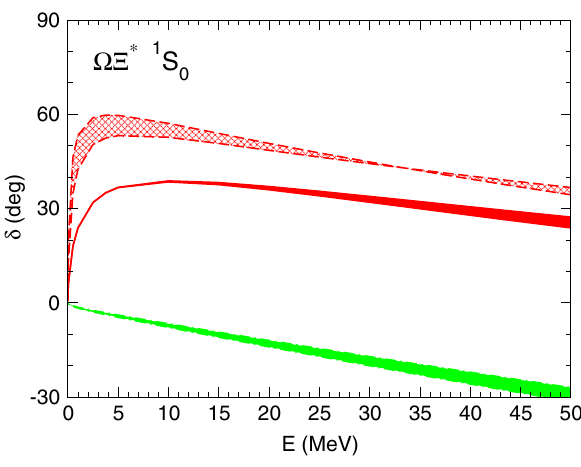
Fig. 4 Prediction for the Ξ ∗ Ω 1 S 0 phase shift with isospin I = 1 / 2 based on the ΩΩ result and SU(3) symmetry. Same description of curves as in Fig.